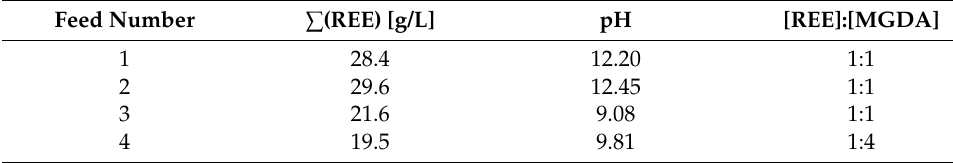
Table 3. Compositions of the feed solutions used in the